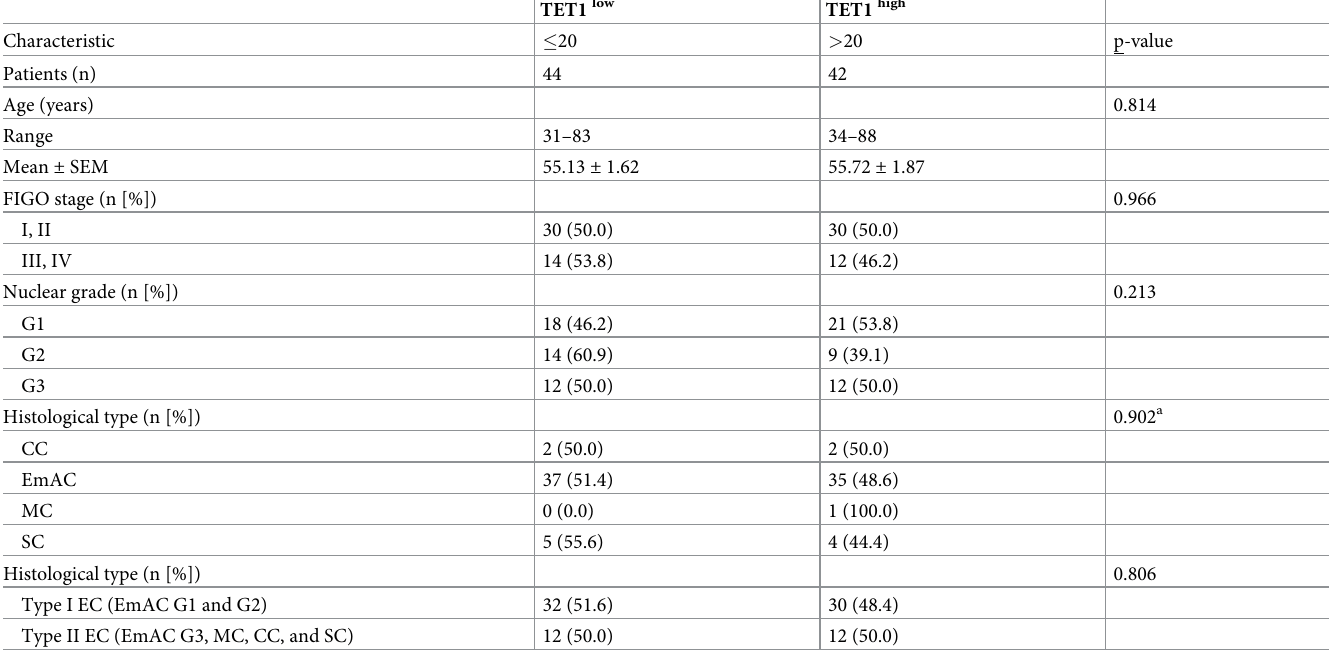
Table 3. Association of TET1 expression score with clinicopathological features in EC.